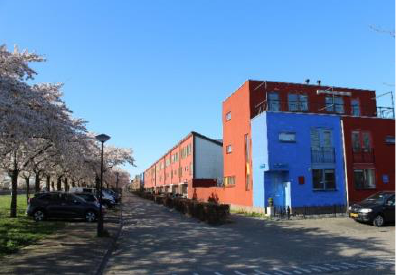
Figure 2. Cherry-lined avenue with red and blue houses (courtesy of Author 2).